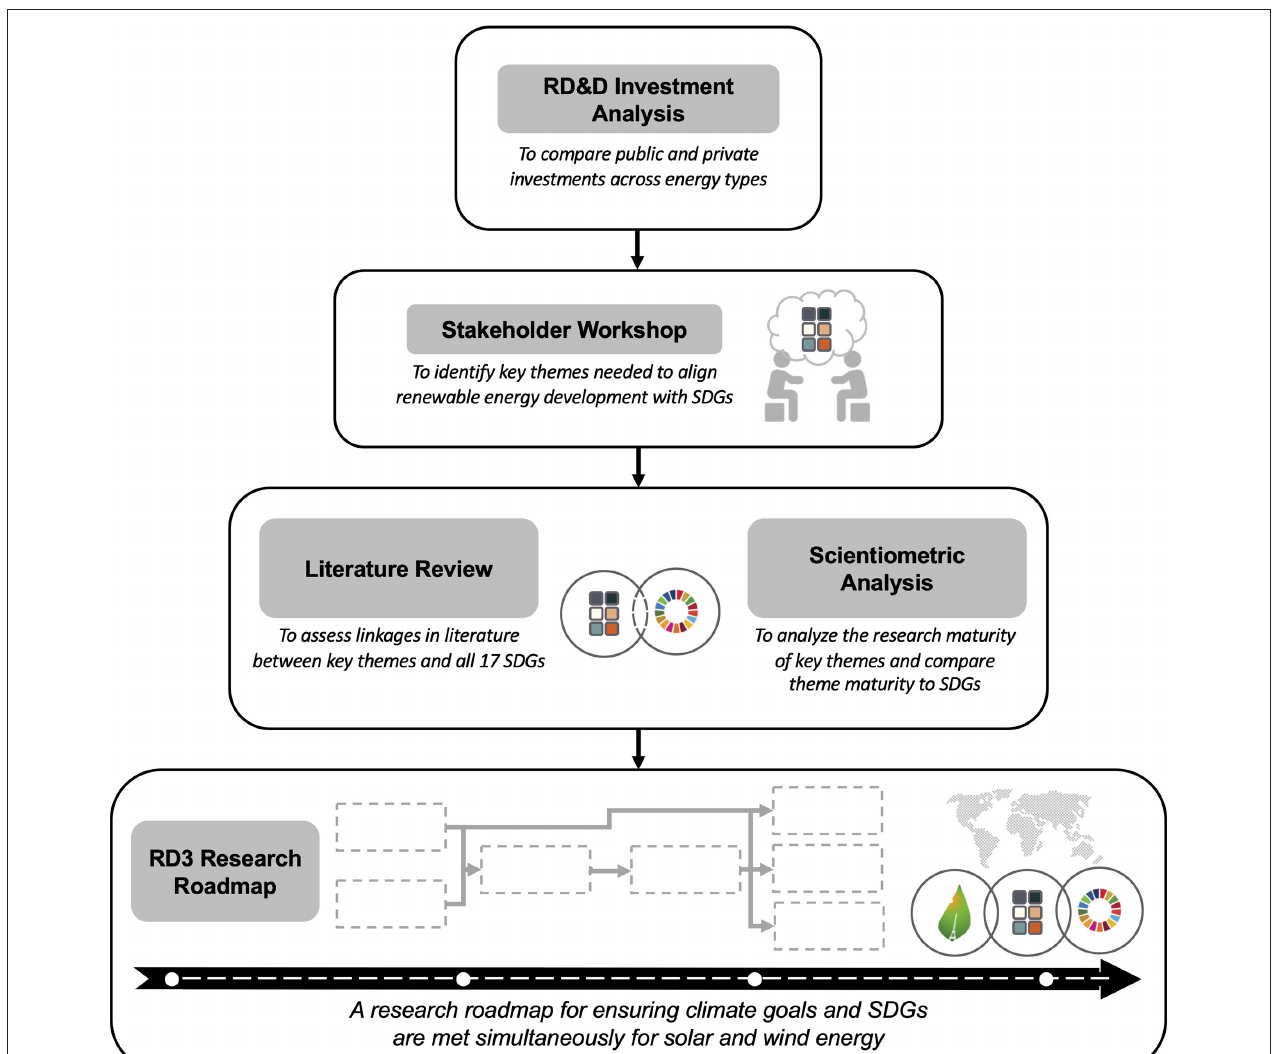
FIGURE 1 | Research work flow showing multi-disciplinary, hierarchical research activities. We led an RD&D investment analysis, stakeholder workshop leading to the development of key research themes (represented by the six squares), literature review, and scientiometric analysis, which collectively informed the development of a research roadmap for ensuring climate goals (represented by the Paris Agreement “green leaf” icon) and the United Nations Sustainable Development Goals (SDGs, represented by the color wheel icon) are mutually reinforcing for the renewable power sector. Graphics use icons reproduced from the Noun Project (https://